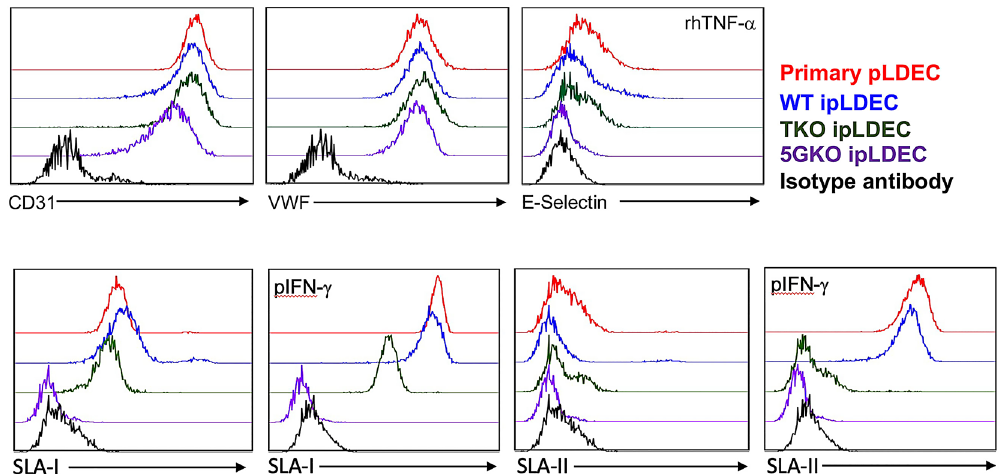
Figure 4. Characterization of primary pLDEC and immortalized porcine liver-derived endothelial cells (ipLDEC). Porcine cells were analyzed for endothelial cell markers, including cell surface expression of CD31, intracellular expression of von Willebrand factor (VWF), and E-selectin (rhTNF-α stimulation) by flow cytometry. SLA-I and SLA-II expression in porcine cells before and after porcine IFN-γ stimulation (pIFN-γ) were examined by flow cytometric analysis using specific antibodies. Primary pLDEC (passage 15–20) and ipLDEC (passage 20–30 after immortalization) were used for characterization.